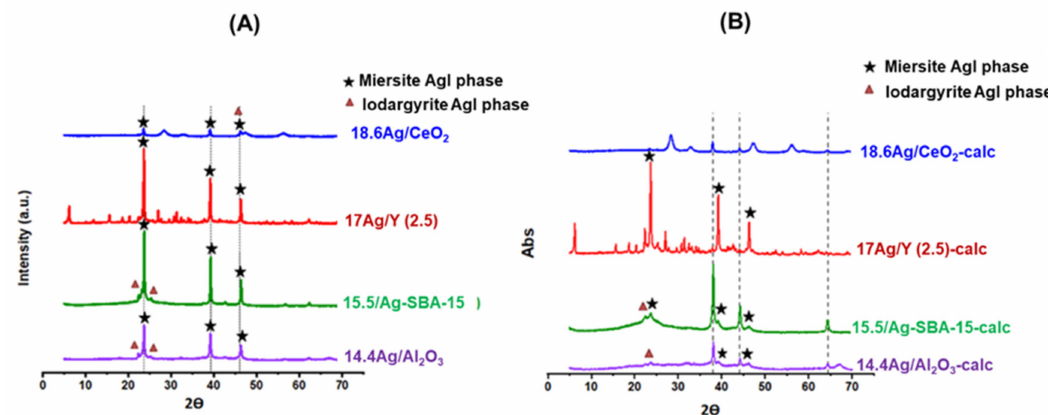
Figure 6. X-ray diffractograms of silver-impregnated adsorbents after CH 3 I adsorption tests: ( A ) before calcination and ( B ) after calcination. On Figure ( B ), dotted lines indicate the positions of the main reflections associated with remaining silver nanoparticles having not reacted with CH 3